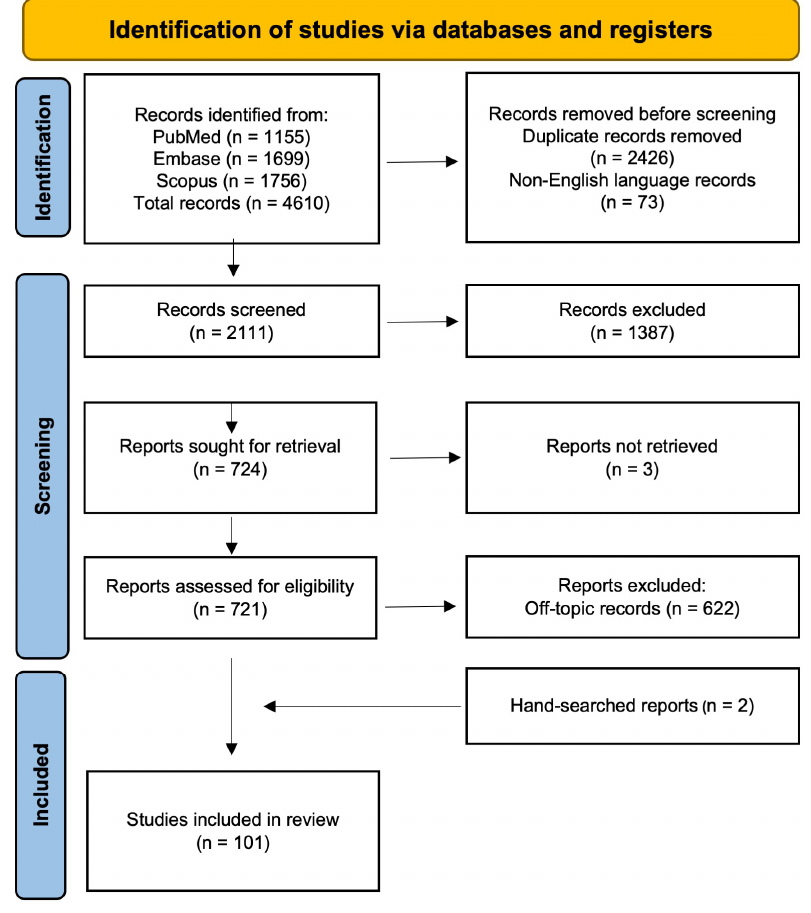
Figure 1. PRISMA diagram showing the flow of information through the different phases of the systematic review.